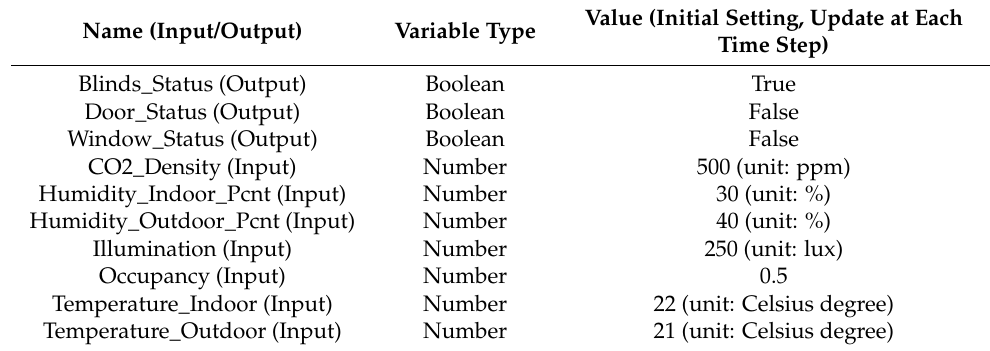
Table 2. Parameters defined in the ABM for model input and output as information